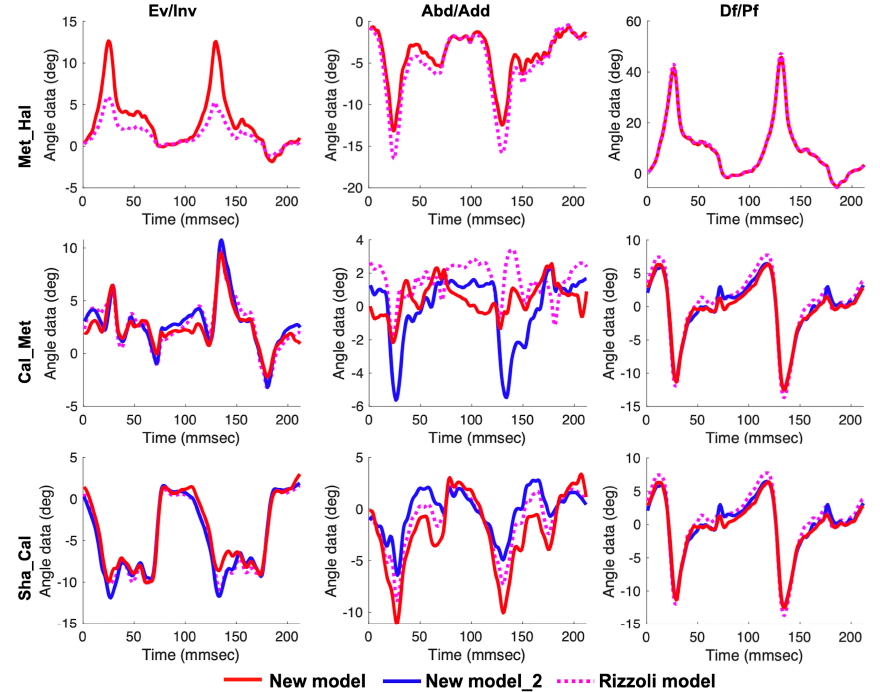
Figure 10. Left to right, the temporal patterns of rotation in the frontal, transverse, and sagittal planes during gait. New model (red solid line), New model_2 (blue solid line), and the Rizzoli model (pink dot line) are shown. First to third row in order, the three joint angles (Met_Hal, Cal_Met, and Sha_Cal) are